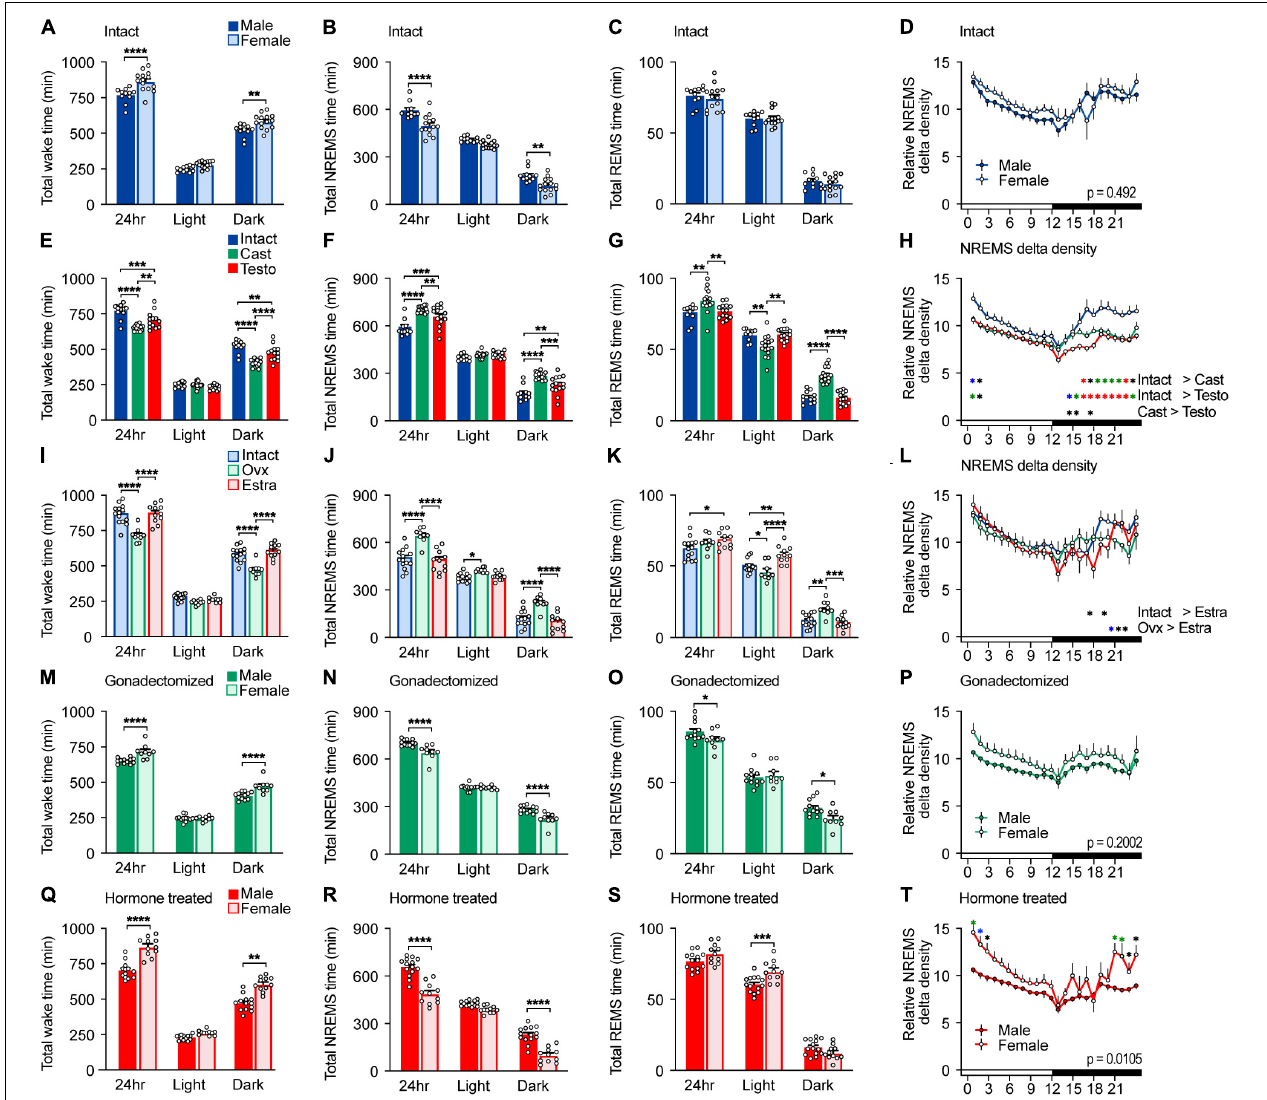
FIGURE 1 | Sleep/wake behavior of intact, gonadectomized, and hormone-supplemented mice. (A–D) Total wake time (A) , total non-rapid eye movement sleep (NREMS) time (B) , total REMS time (C) , and NREMS delta power density (D) of intact male and female mice for 24 h; 11 male mice and 14 female mice. Two-way ANOVA followed by Sidak’s test. (E–H) Total wake time (E) , total NREMS time (F) , total REMS time (G) , and NREMS delta power density (H) of male mice. Two-way ANOVA followed by Sidak’s test. (I–L) Total wake time (I) , total NREMS time (J) , total REMS time (K) , and NREMS delta power density (L) of female mice. Two-way ANOVA followed by Sidak’s test. (M–P) Total wake time (M) , total NREMS time (N) , total REMS time (O) , and NREMS delta power density (P) of gonadectomized male and female mice; 16 male mice and 14 female mice. Two-way ANOVA followed by Sidak’s test. (Q–T) Total wake time (Q) , total NREMS time (R) , total